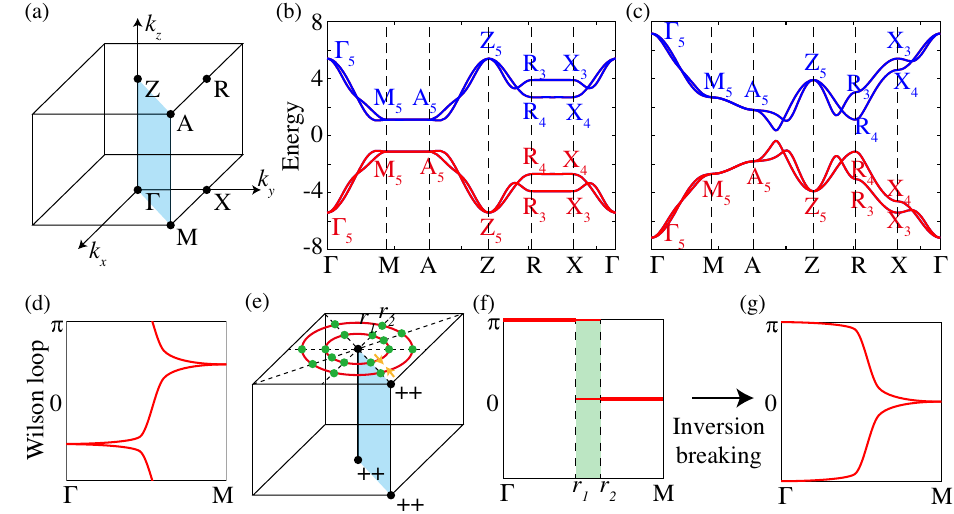
FIG. 11. Fu ’ s topological crystalline insulator [24] and the generalized symmetry eigenvalue criterion. (a) Brillouin zone of the SG P 4 . (b) Band structure and the irreps in the trivial phase of Fu ’ s model ( t 0 ¼ 0 ). (c) Band structure and the irreps in the topological phase of Fu ’ s model ( t 0 ¼ 2 ). The irreps in panels (b,c) are the same as the EBR induced from p orbitals at the 1 a position. (d) An illustration of x;y ; k the nontrivial Wilson loop spectrum. The Wilson loop operator W ð k is calculated along the k direction. The spectrum is plotted x y Þ z Γ → M. The crossing at Γ and M is protected by C 4 =mmm , which is a supergroup of P 4 , a ; k along the line ð k 4 and T . (e) For SG P x y Þ ¼ Z Z 2 invariant can be defined based on the inversion eigenvalues [Eq. (E2)]. This 2 invariant implies a nodal ring semimetal. The red circles represent the two nodal rings. The four dashed lines represent the four C 2 rotation axes. (f) The discontinuous Wilson loop spectrum of the nodal ring semimetal. (g) If the symmetry is slightly broken such that P 4 =mmm reduces to P 422 and no gap closing happens at Γ , M, Z, A, the Wilson loop will have a winding protected by C 4 and T